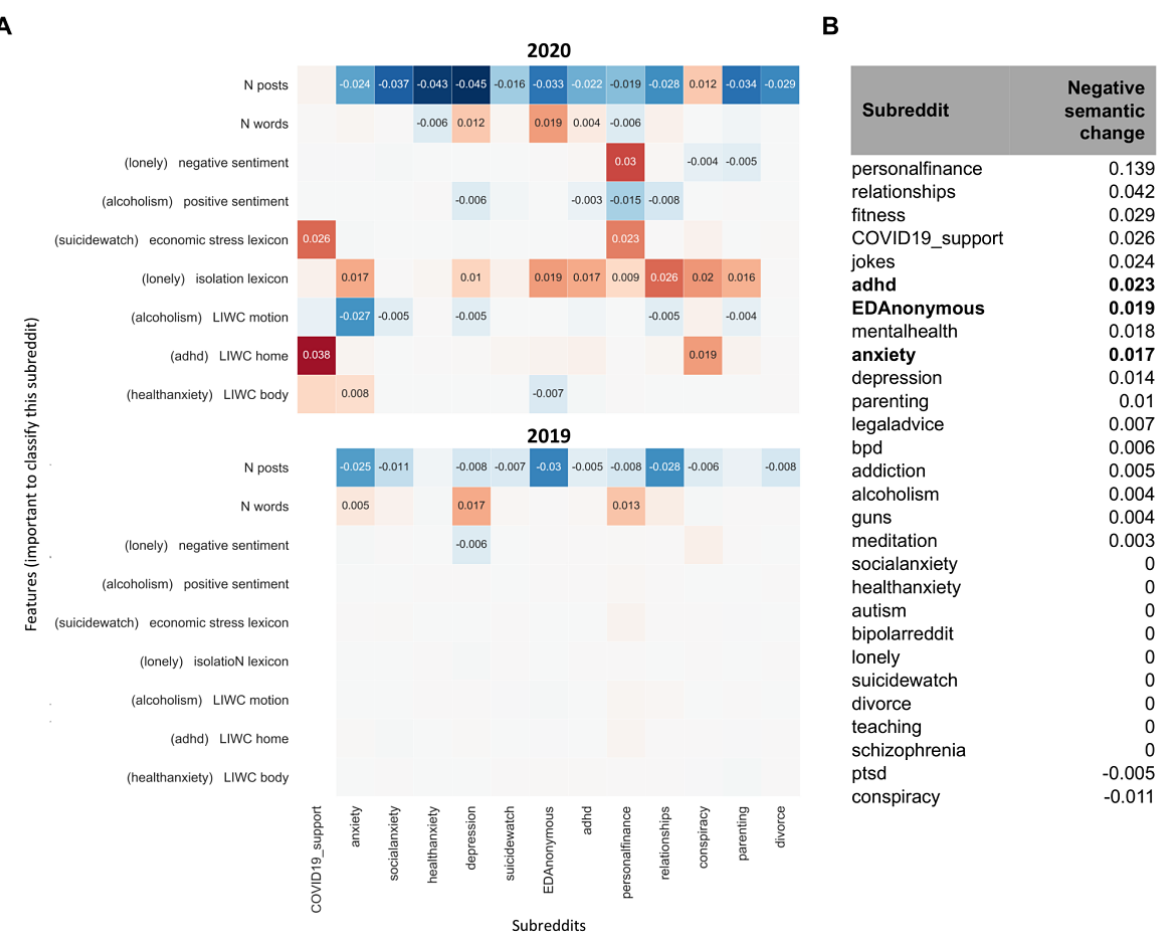
Figure 2. Trend analysis of linguistic features over time. A) Significant change in average feature values from January to April 2020 and 2019 across subreddits. COVID19 support subreddit was created in 2020 and, therefore, does not appear in 2019. Features important for classifying a subreddit are added to the y-axis. Change is defined by slope x R^2 (ie, increases have a positive slope and tend toward red, decreases have a negative slope and tend toward blue). Significant trends after multiple comparison correction on full results are displayed. There is significantly more absolute change in 2020 than in 2019 ( P <.001) and 2018 ( P <.001). B) Rank of subreddits by the amount of negative semantic change throughout COVID-19 (January 1, 2020, to April 20, 2020) across significant full results. In bold are the mental health subreddits with the most negative semantic change using the following features with emotional valence: negative sentiment; the lexicons about economic stress, isolation, substance use, guns, domestic stress, and suicidality; LIWC measures of anger, anxiety, death, negations, negative emotion, and sadness; and three positive features inversely weighed, compound sentiment, positive sentiment, and positive emotion. r/ptsd and r/conspiracy decreased in negative semantic features. adhd: attention-deficit/hyperactivity disorder; bpd: borderline personality disorder; EDanonymous: Eating Disorders Anonymous; LIWC: Linguistic Inquiry and Word Count; ptsd: posttraumatic stress